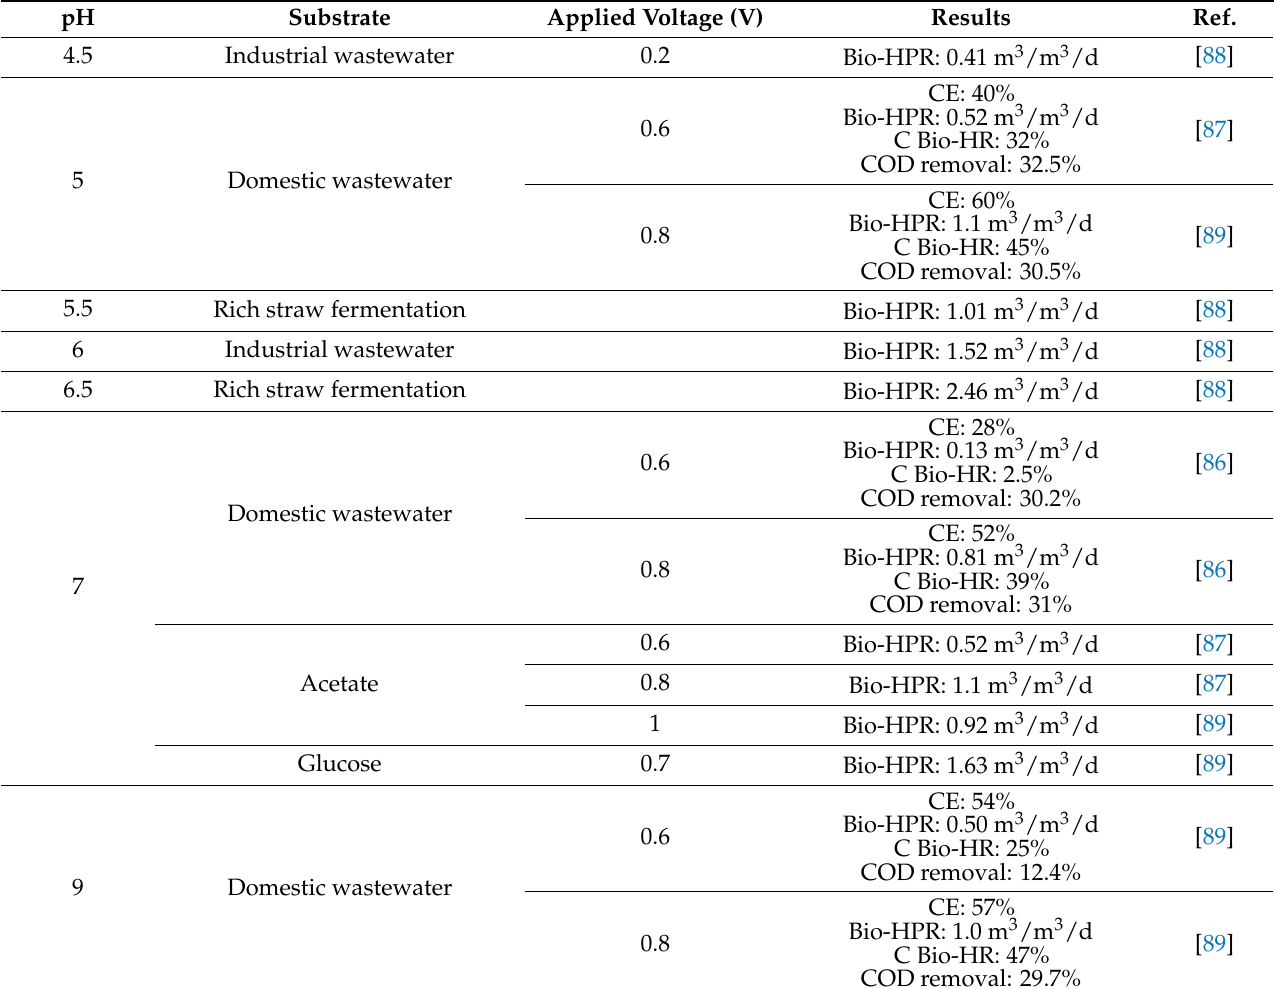
Table 4. Effect of pH on performance of